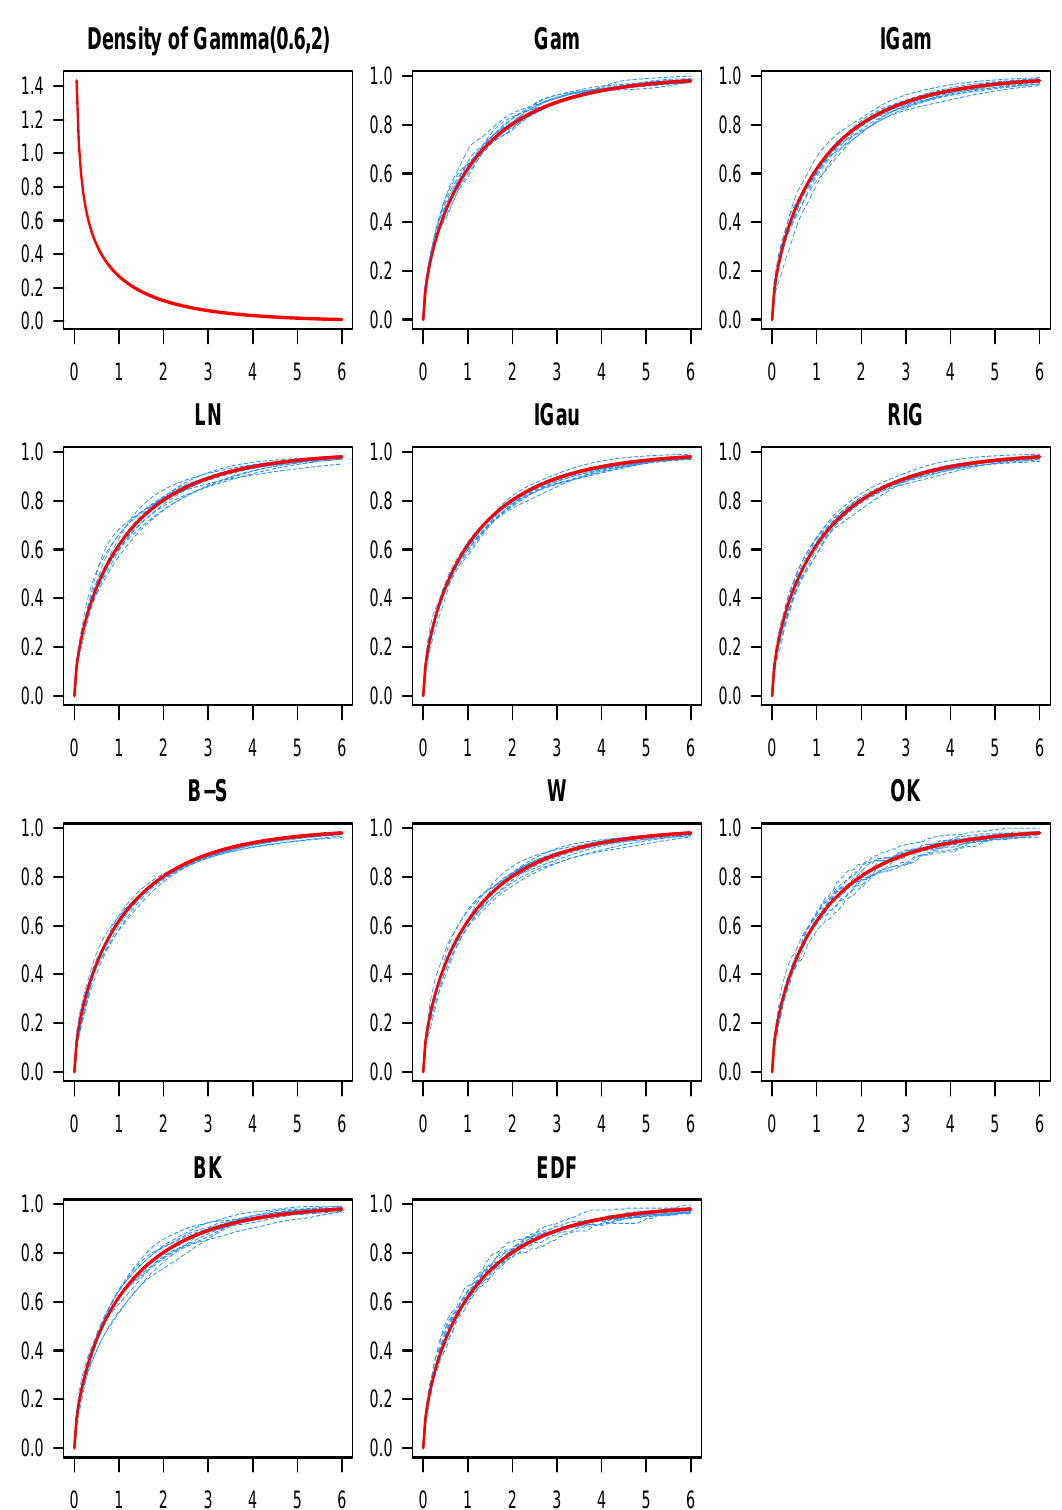
Figure 3. The Gamma ( 0.6,2 ) density function appears on the top-left, and the target c.d.f. is depicted in red everywhere else. Each plot has ten estimates in blue for the Gamma ( 0.6,2 ) c.d.f. using one of the ten estimators (the name of the corresponding kernel is indicated above each graph) and n =